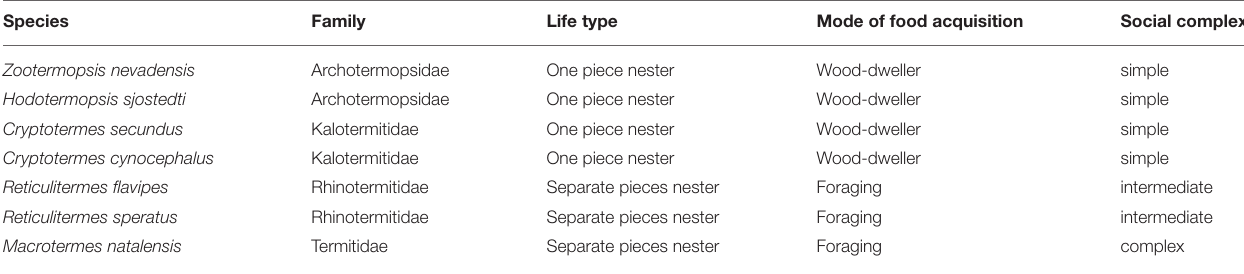
TABLE 2 | Traits for main termite study species mentioned in the text.